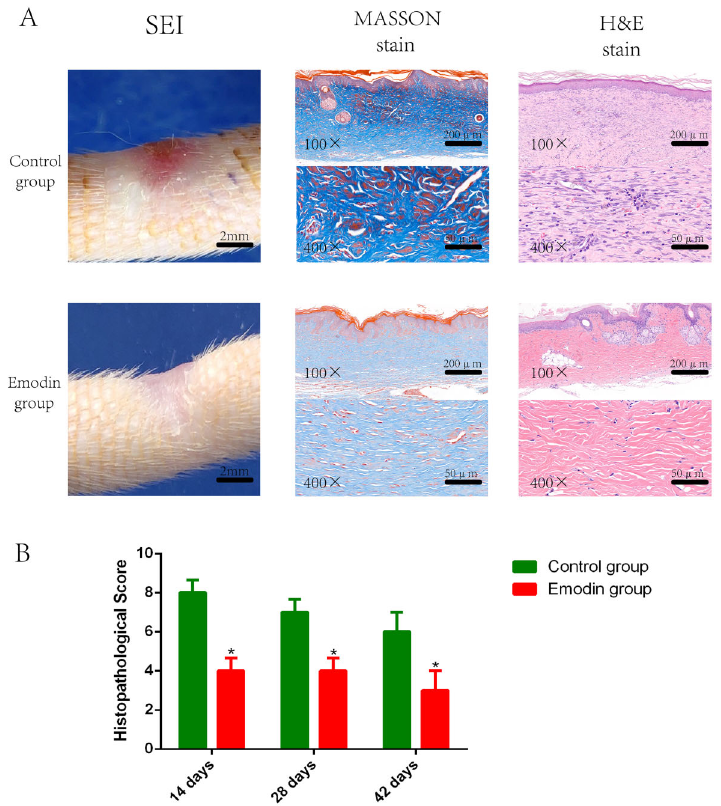
Figure 2. Histopathological changes induced by emodin treatment in a rat model with tail hypertrophic scar. A and B , After modeling of the tail hypertrophic scar in rats, the animals were treated with vehicle or emodin. The scar samples at 14, 28, and 42 days after modeling were assessed and scored for scar elevation index (SEI), collagen structure, and in fl ammation. A , Representative images show the results of SEI (left), Masson ’ s trichrome staining ( fi brosis; middle), and hematoxylin and eosin (H&E; in fl ammation) staining (right) at 28 days after modeling. B , Histopathological scores at the indicated times (sums of all three subscores of in fl ammation, fi brosis, and SEI) in the Control and Emodin groups are summarized. Scores were obtained from experienced pathologists in a double-blinded manner. Data are reported as means ± SD for n=9 for each group. *P o 0.05 vs the Control group (two-tailed t -test). Scale bars, 2 mm in the SEI images, 200 m m in the 100 (cid:1) fi eld, and 50 m m in the 400 (cid:1) fi eld in the micrographs of Masson ’ s or H&E